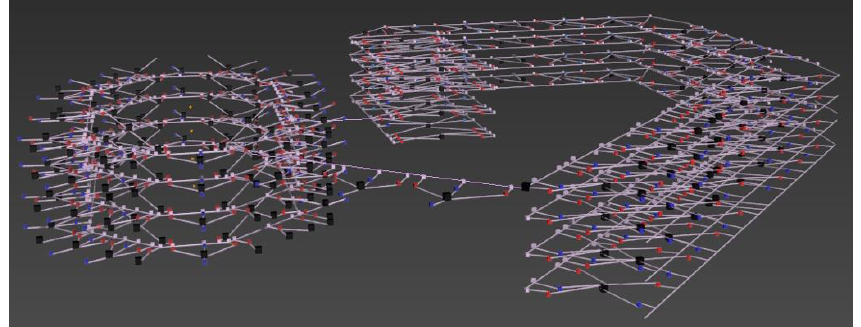
Figure 7. Indoor 3D road network model.